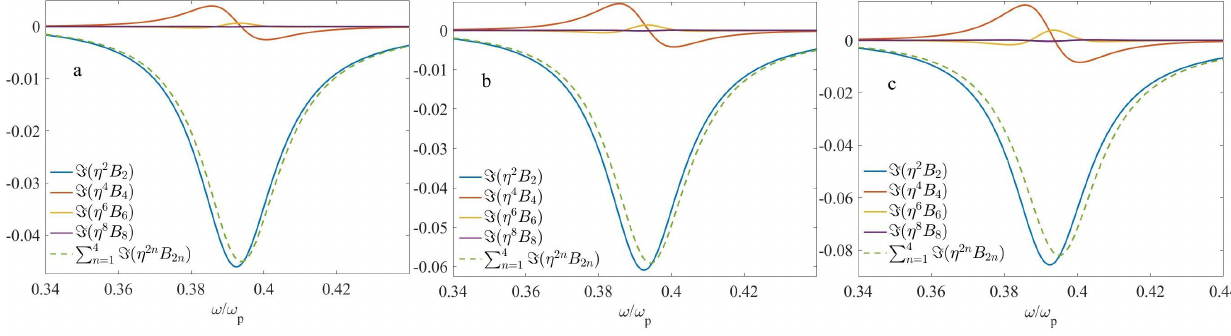
Figure 5. The frequency dependencies of the imaginary part of nonlocal corrections to the effective permittivity at f 1 = f 2 = 0.5: ( a ) d 1 / d = 0.25, d 2 / d = 0.2, d 3 / d = 0.25, d 4 / d = 0.3, ( b ) d 1 / d = 0.25, d 2 / d = 0.15, d 3 / d = 0.25, d 4 / d = 0.35, and ( c ) d 1 / d = 0.25, d 2 / d = 0.1, d 3 / d = 0.25, d 4 / d = 0.4. Table 2. The geometrical parameters which correspond to Figure 5. f 2 d 1 / d d 2 / d d 3 / d d 4 / d µ Label 0.25 0.2 0.25 0.3 0.005 a 0.5 0.25 0.15 0.25 0.35 0.02 b 0.25 0.1 0.25 0.4 0.045